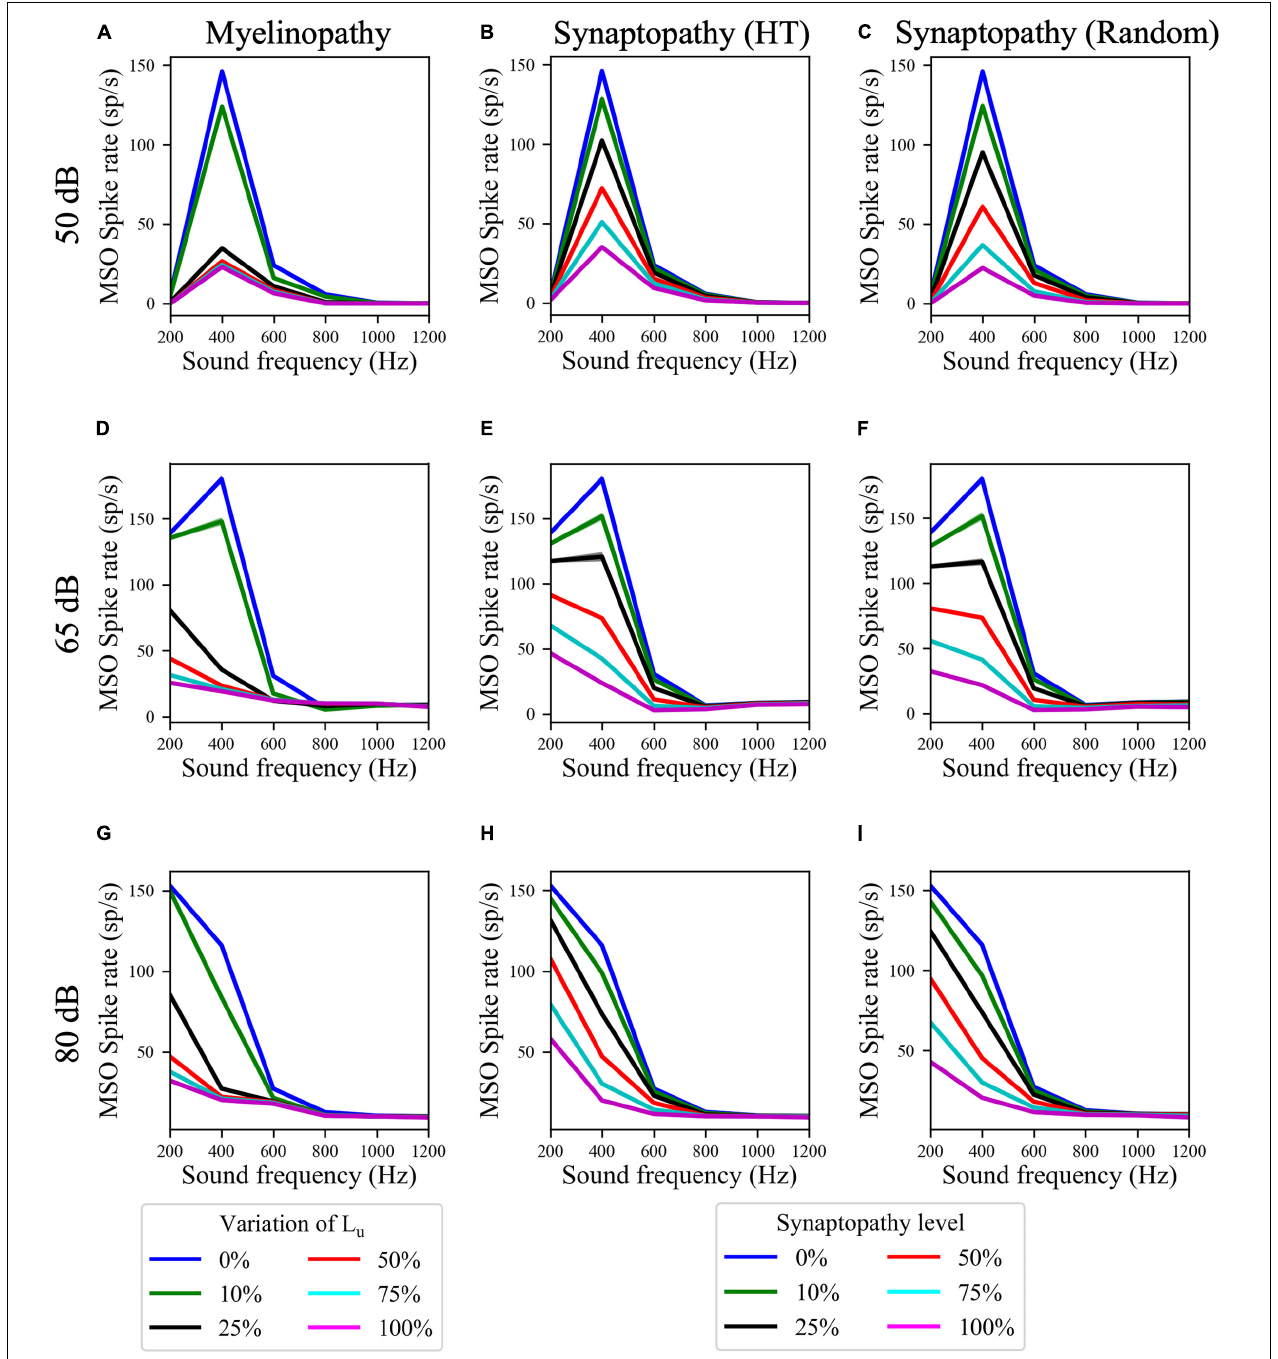
FIGURE 6 | Resonance properties of MSO cells resulted in higher MSO spike rates at resonant frequencies for all peripheral auditory disruption conditions. (A–I) MSO spike rates in response to 50 dB (A–C) , 65 dB (D–F) , and 80 dB (G–I) sound stimuli of frequencies varying from 200 to 1,200 Hz in case of myelinopathy (A,D,G) , synaptopathy at HT (B,E,H) and random synaptopathy (C,F,I) . Note that the resonant frequency (frequency with the highest MSO activity) decreased with increasing sound levels.